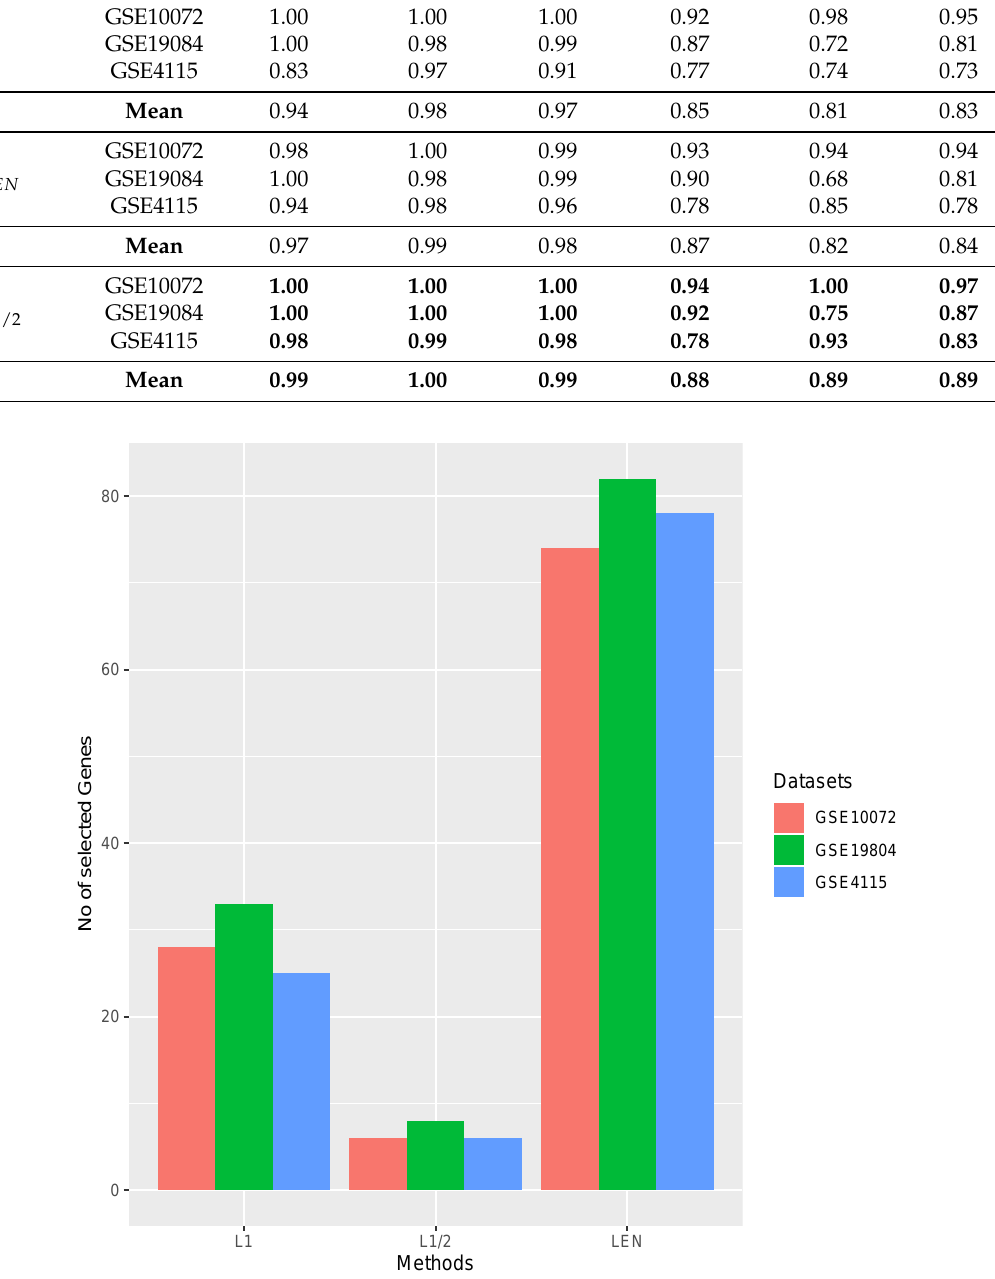
Figure 1. The number of genes selected by L 1 , L EN , and L 1/2